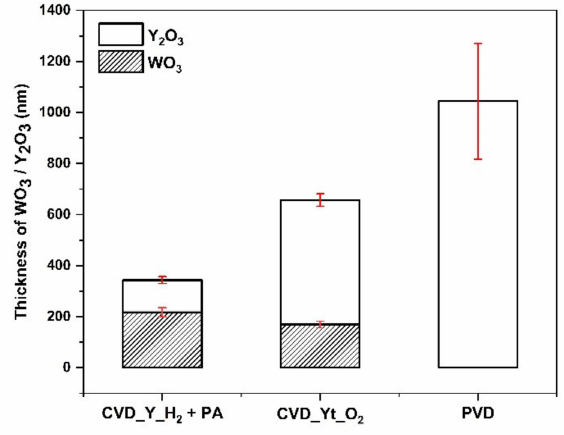
Figure 3. Graphical representation of the formation of WO 3 in response to the fabrication of Y 2 O 3 on W f using CVD and PVD routes.